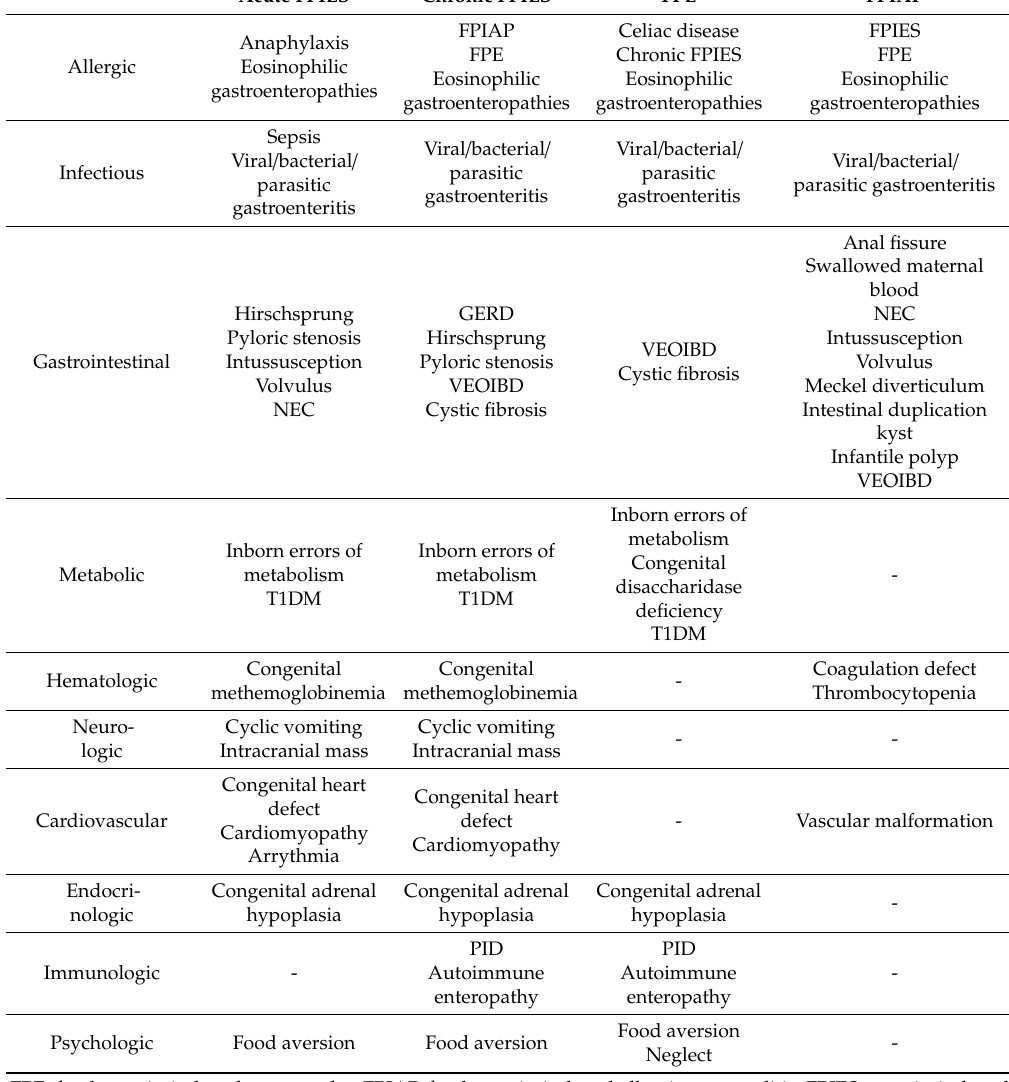
Table 4. Di ff erential diagnosis of non-IgE-mediated gastrointestinal food allergies. Acute